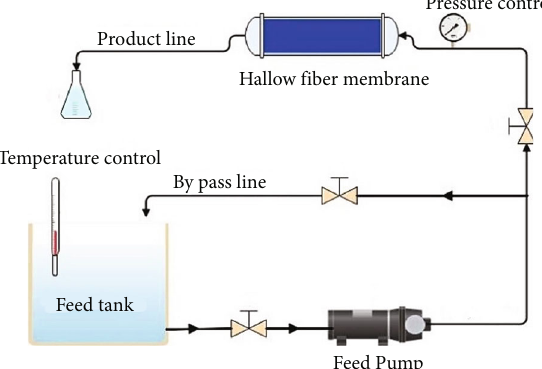
Figure 2: Schematic diagram of water separation system setup.